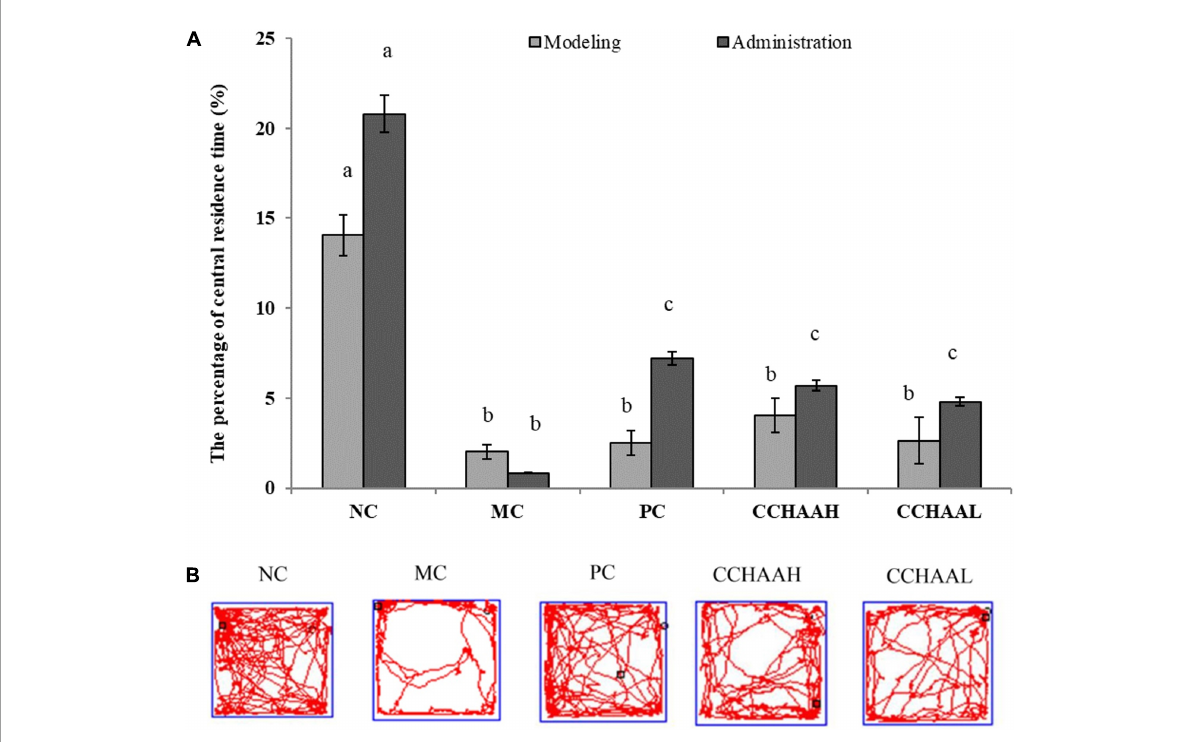
FIGURE2 (A) The effects of CCHAA formula on the behaviors of mice in the open-field test. Different letters indicate significant differences ( P < 0.05). (B) The total movement tracked in OFT: The black dots indicate where the mice started the test, with the black boxes showing where the mice stopped after the 10-min test, and the red lines were the recorded motion track/routes of